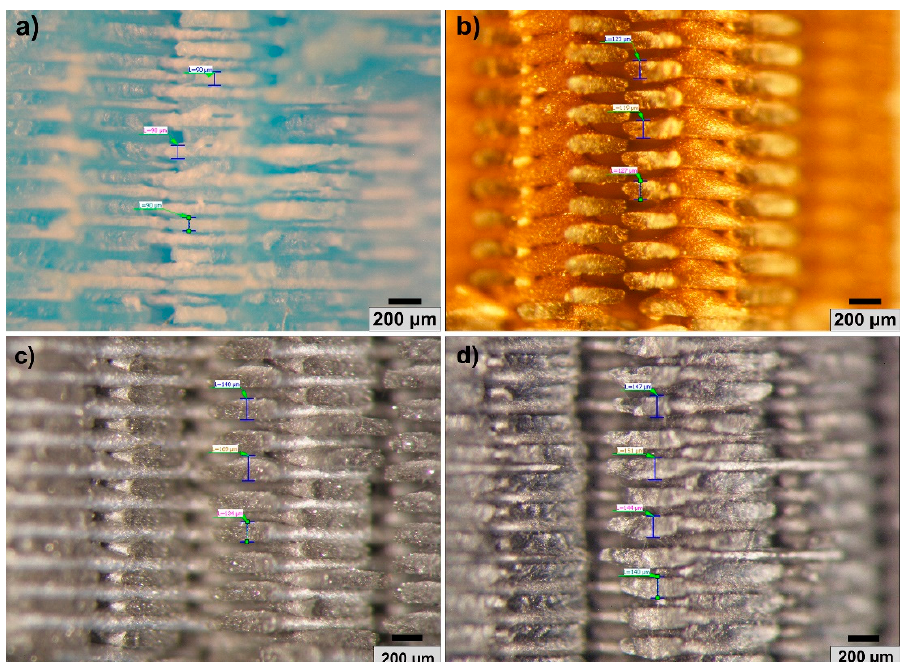
Figure 9. Macrostructural aspects at stereomicroscope of experimental samples in transversal cross section, with 100% interior fill percentage and 60 ° thread deposition ( a ) polylactic acid material; ( b ) polylactic acid material with copper particles; ( c ) polylactic acid material with aluminum particles; ( d ) polylactic acid material with graphene particles. Results regarding fourier transform infrared (FTIR) analysis are given in Figure 10.